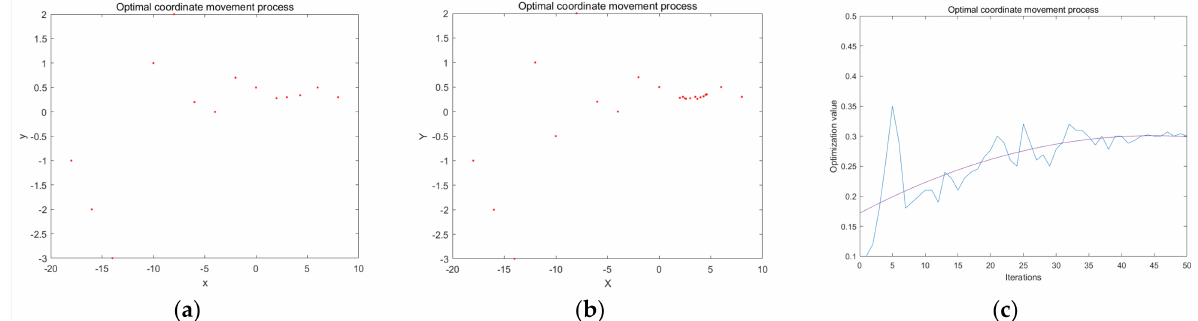
Figure 7. ( a ) Early iteration stage of the artificial fish school algorithm; ( b ) late iteration stage of the artificial fish school algorithm; ( c ) final result of the artificial fish school algorithm.